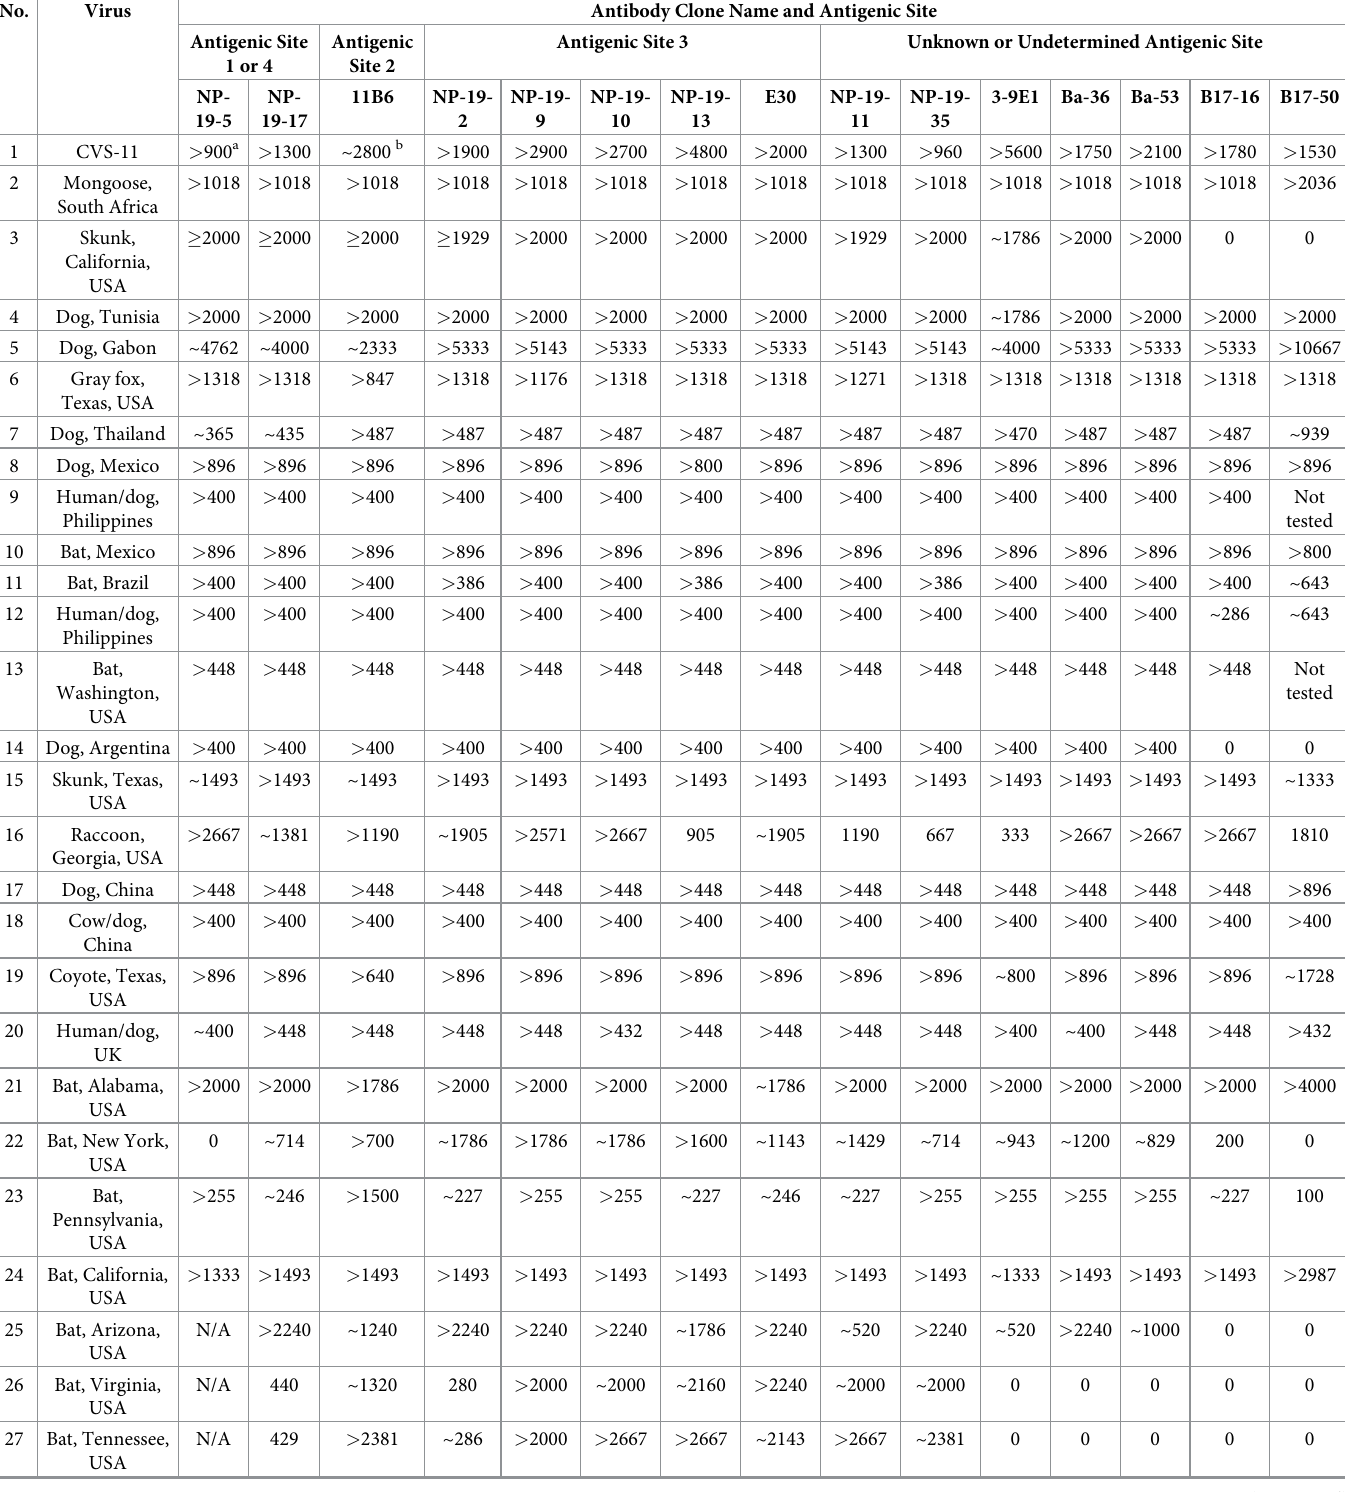
Table 2. The VNA activity test for 15 mAbs against selected Iyssaviruses.